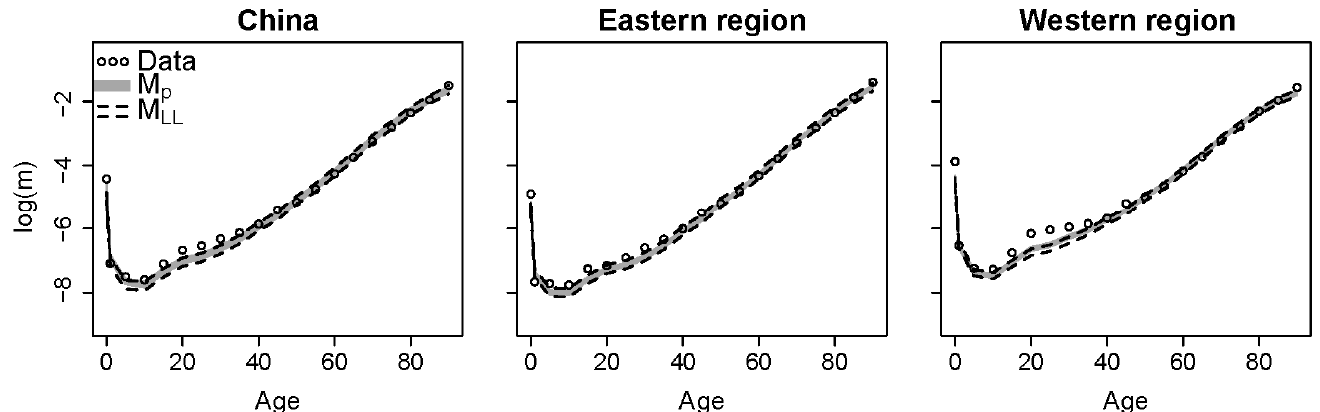
Figure 3. In-sample forecasts for China and two regions in 2005.